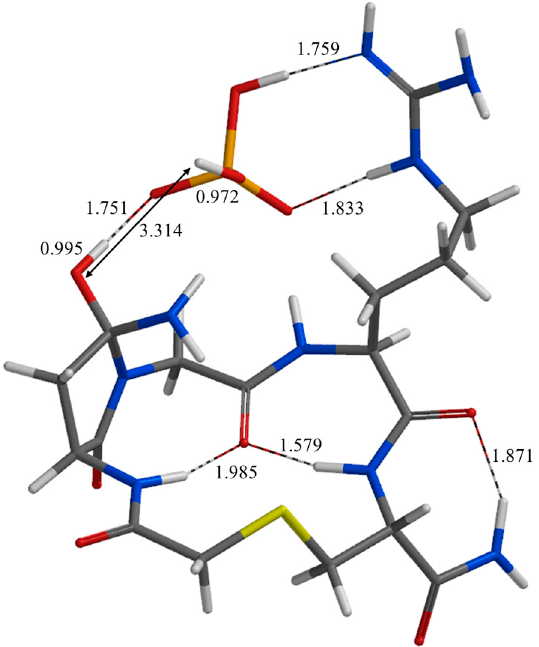
Figure 7. The geometry of IC2 (intermediate complex 2) lying between TS2 (Figure 6) and TS3 (Figure 8). Selected interatomic distances are shown in Å. Grey: carbon; white: hydrogen; blue: nitrogen; red: oxygen; orange: phosphorus; yellow: sulfur.